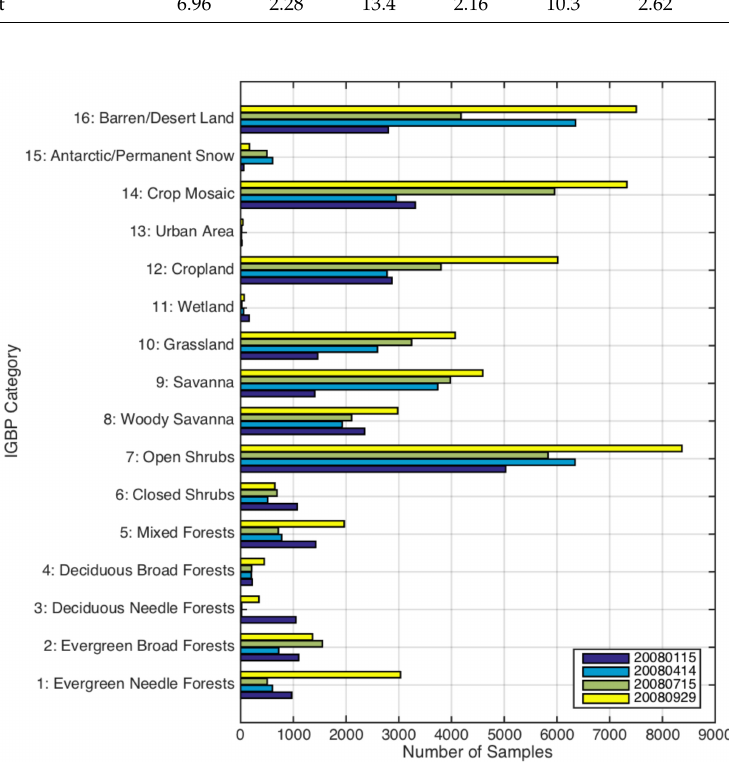
Figure 10. Number of samples for de-biased variances listed in Table